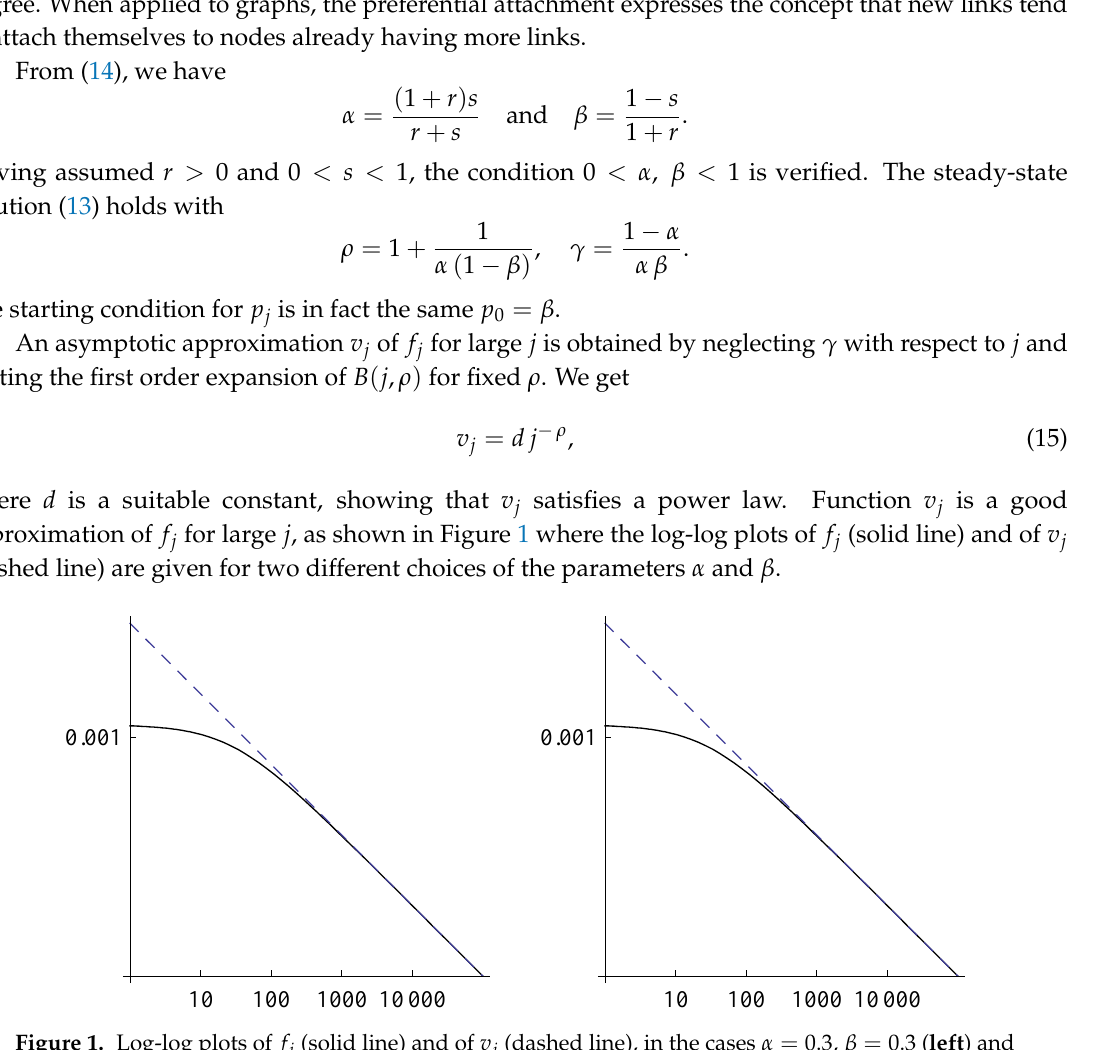
Figure 1. Log-log plots of f j (solid line) and of v j (dashed line), in the cases α = 0.3, β = 0.3 ( left ) and α = 0.5, β = 0.9 ( right